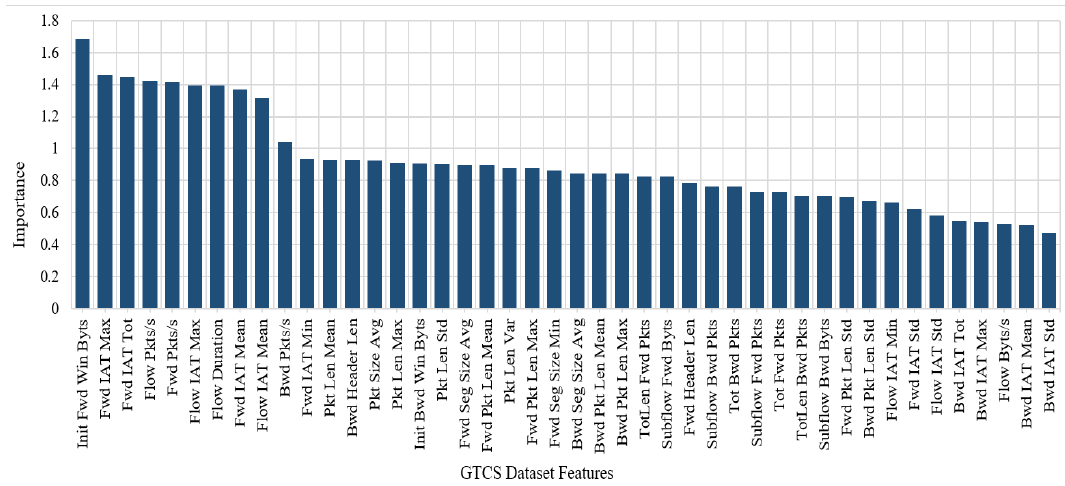
Figure 2. Selected features of GTCS dataset.